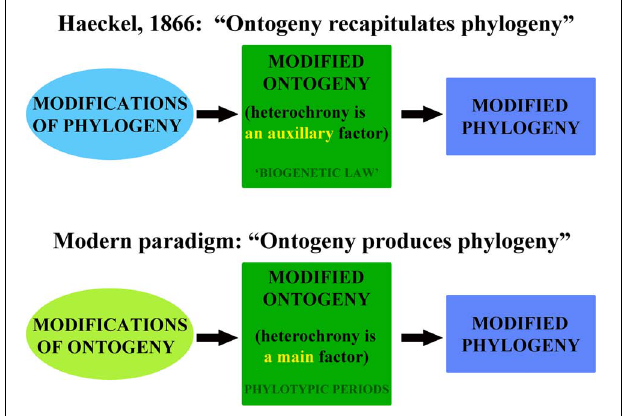
FIGURE 1 | The scheme illustrates changes in the understanding of the “ontogeny and phylogeny” conceptual framework compared with Haeckel’s (1866) and modern paradigm since Garstang (1922) seminal